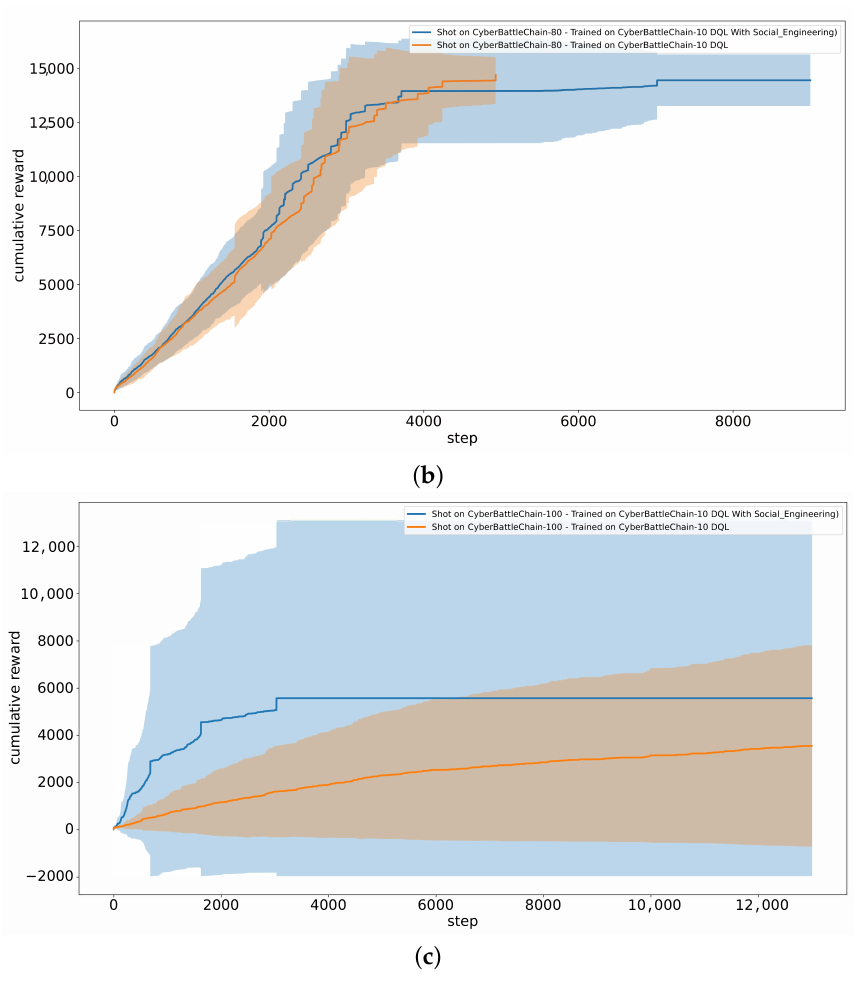
Figure 14. The result of experiment C. ( a ) Variation of the average cumulative reward under the CyberBattleChain-50 test scenario. ( b ) Variation of the average cumulative reward under the CyberBattleChain-80 test scenario. ( c ) Variation of the average cumulative reward under the CyberBattleChain-100 test